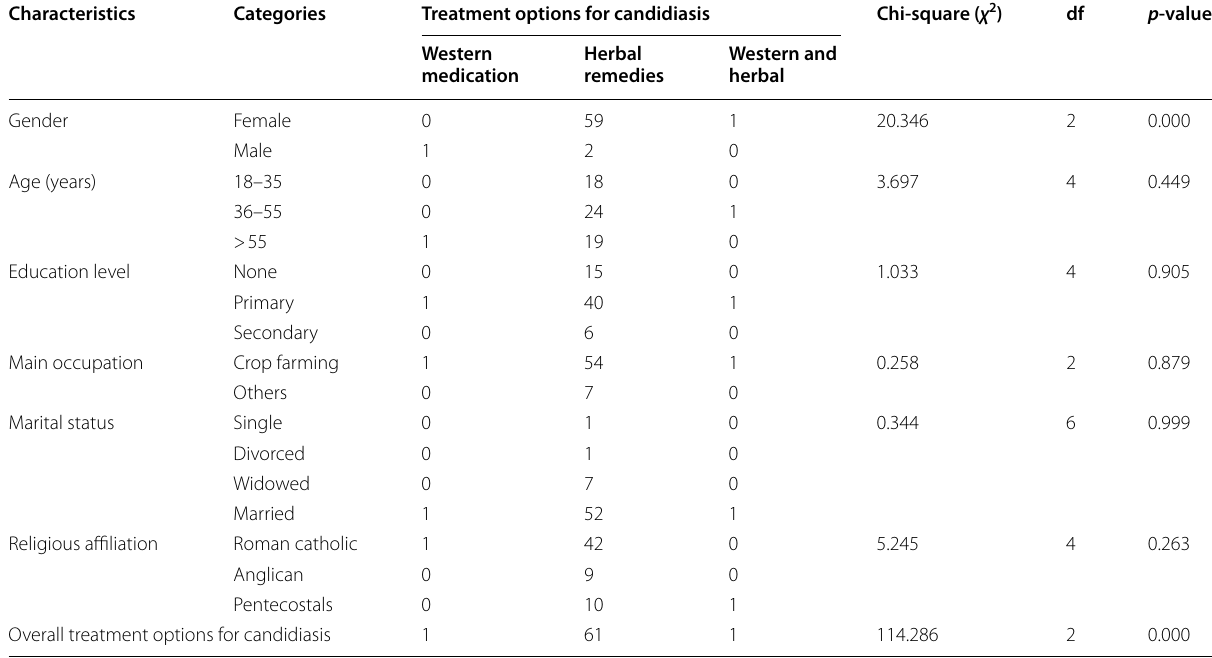
Table 3 Treatment options for candidiasis in relation with gender, age, educational status, occupation, marital status and religion